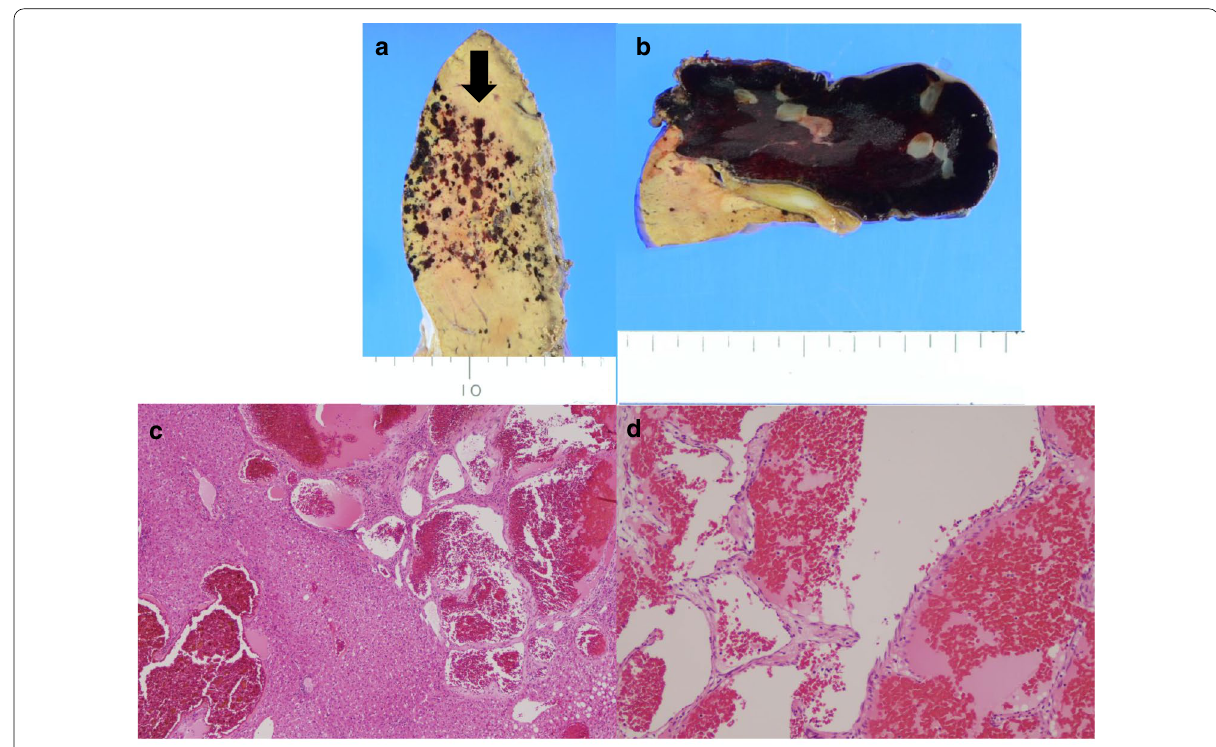
Fig. 5 Histopathological examination of lesions in liver segment IV. a , c The disseminated red spots (black arrow) are areas in which blood vessels aggregated in liver segment IVa. These findings correspond with hemangiomatosis. b , d Microscopic findings of the well-defined tumor in liver segment IVb reveal that the vascular space is filled with blood and lined by endothelial cells, a common finding in